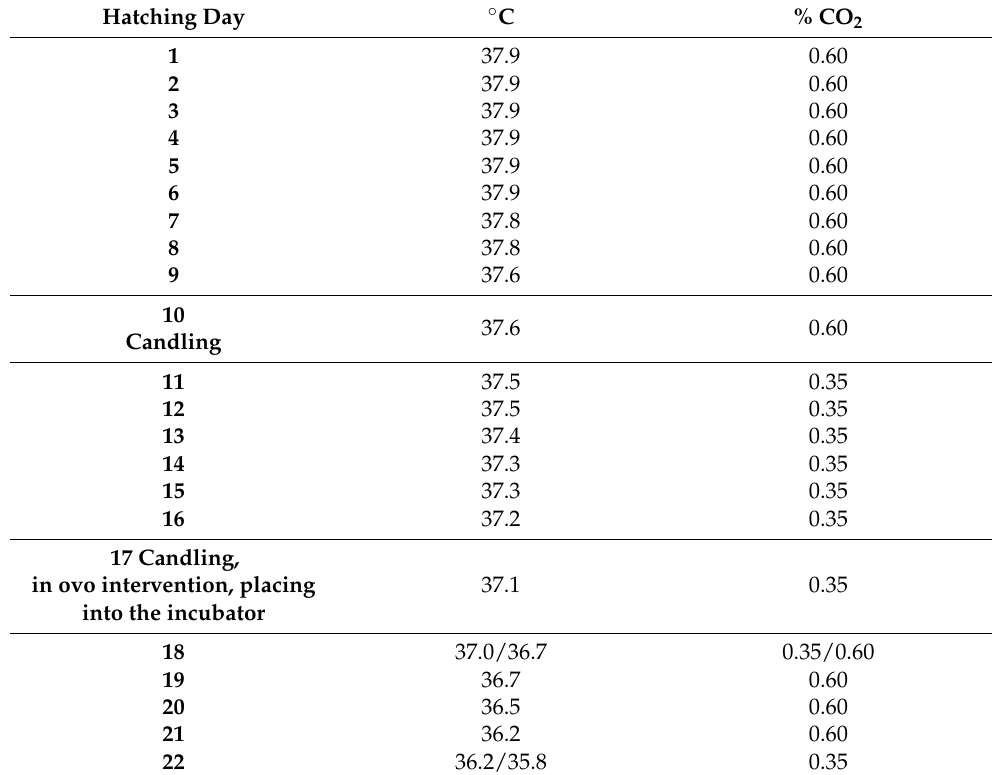
Table 2. Temperature and CO 2 levels during